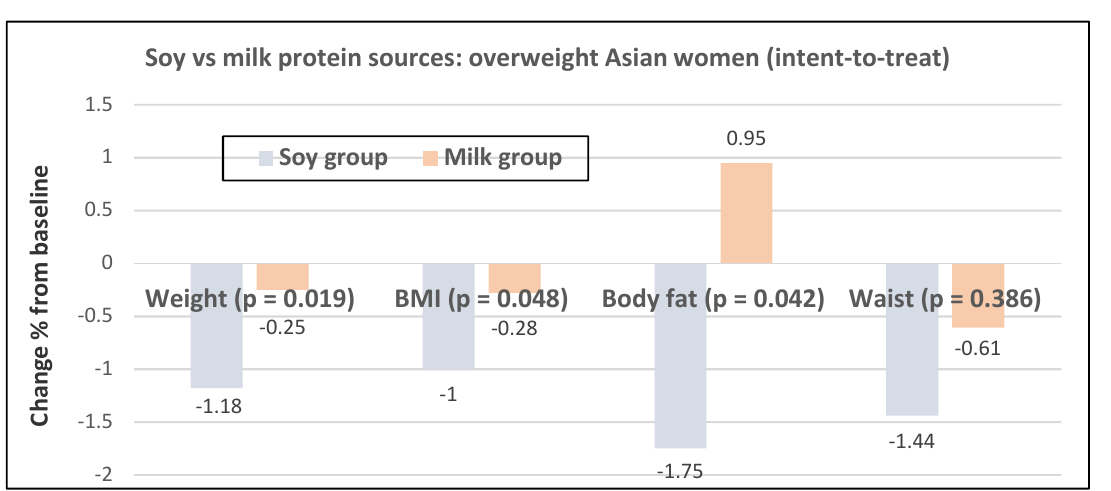
Figure 23. Beans compared to the recommended intake of fruit and vegetable (FV) and whole grains on weight loss in 20 subjects (90% women; mean 47 y and BMI 31) after four weeks (both diets p < 0.001; mean fiber 28g/day) [65].